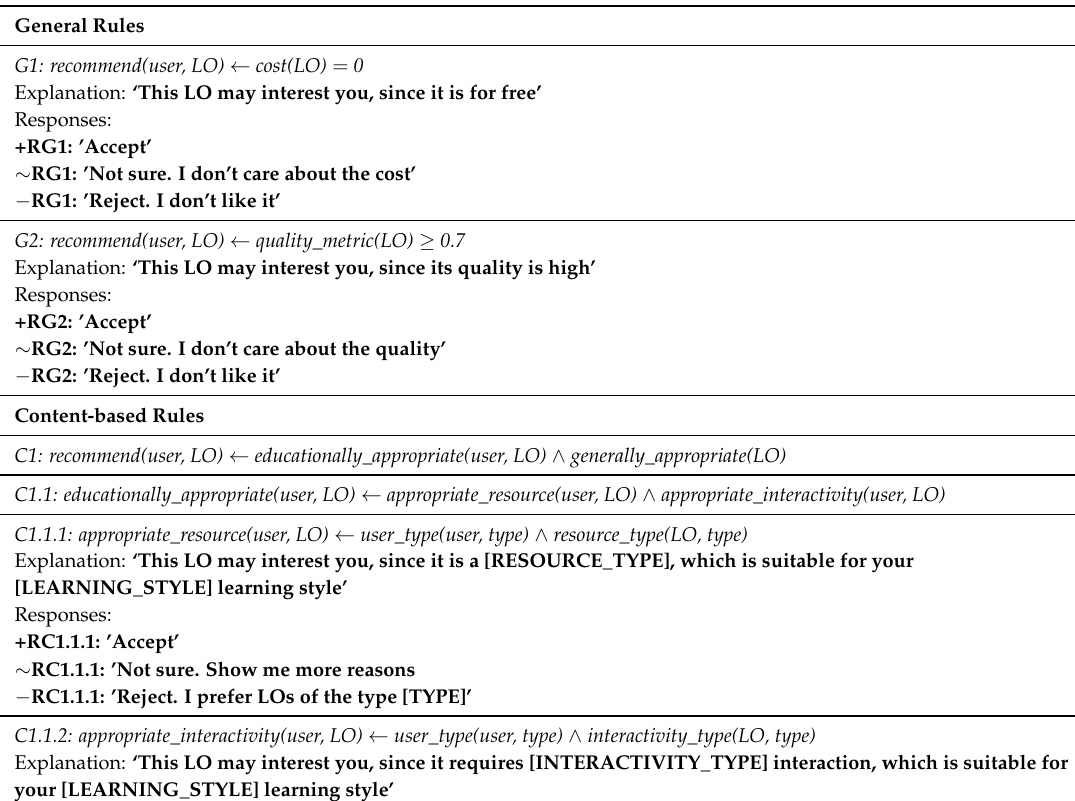
Table 2. C-ERS Defeasible rules and